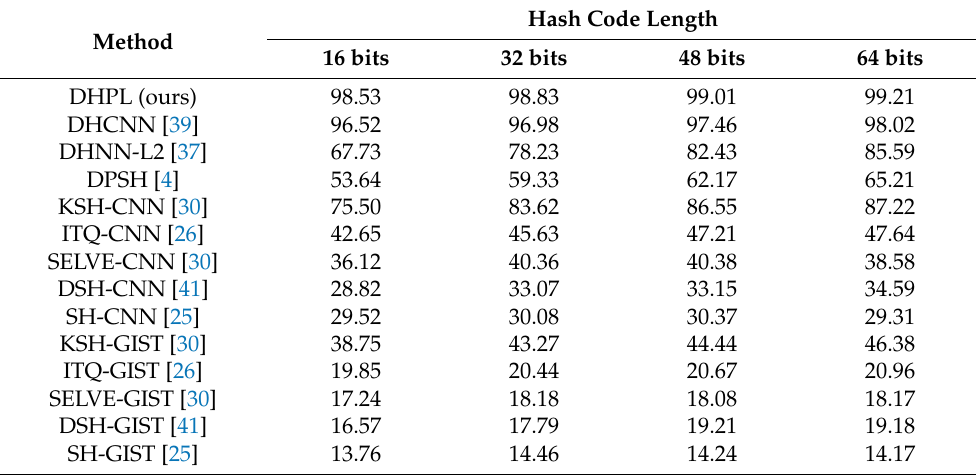
Table 2. mAP retrieval results on the UCMD dataset, and we give separate hash retrieval results for 16, 32, 48, 64 bits. The testing set has 420 images (each category randomly takes 20% of the images). We have thickened the best